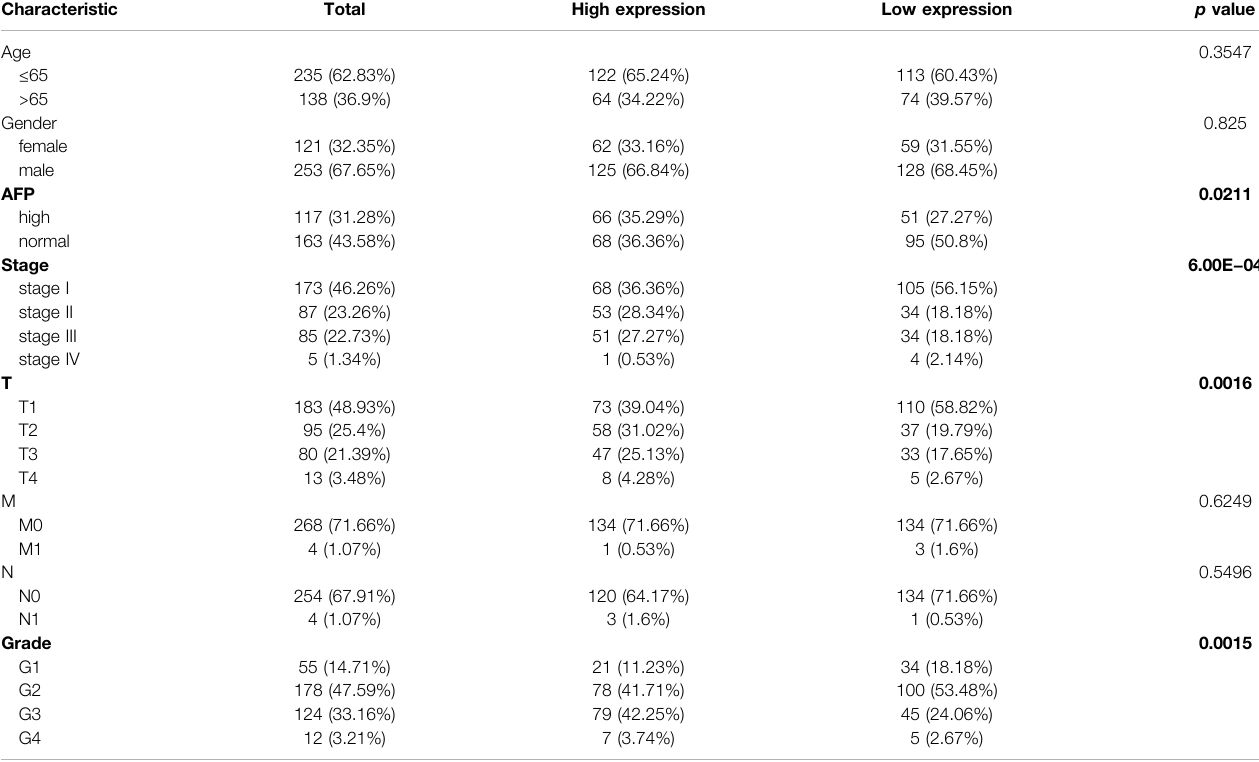
TABLE 1 | Correlations between the RAB42 expression and clinical characteristics of patients with HCC from the TCGA. Characteristic Total High